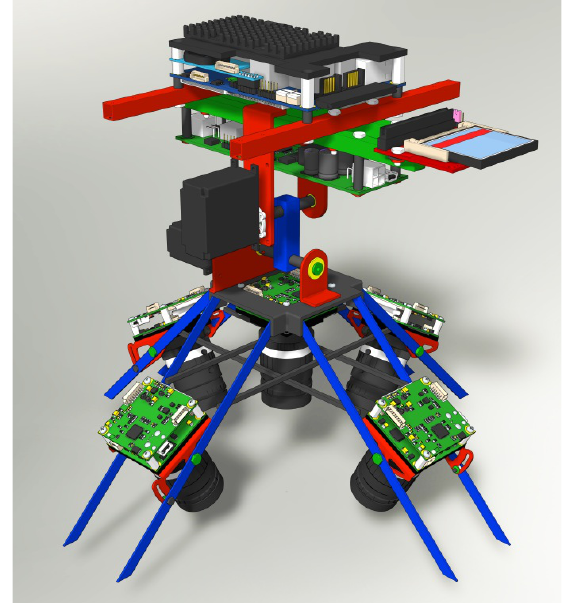
Figure 3: Construction drawing of the "Four Vision" camera system